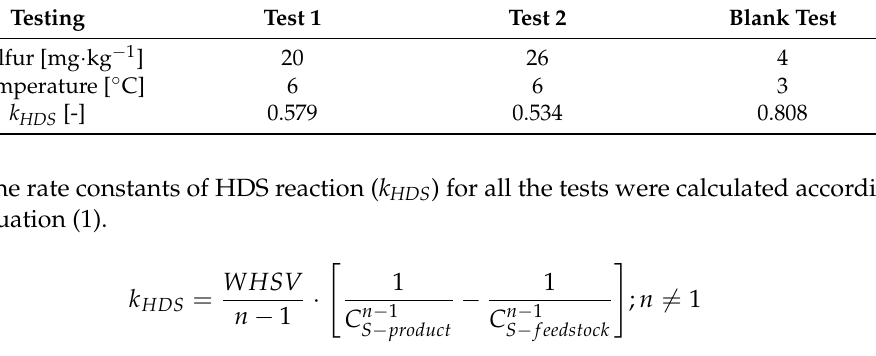
Table 3. Results of the tests.